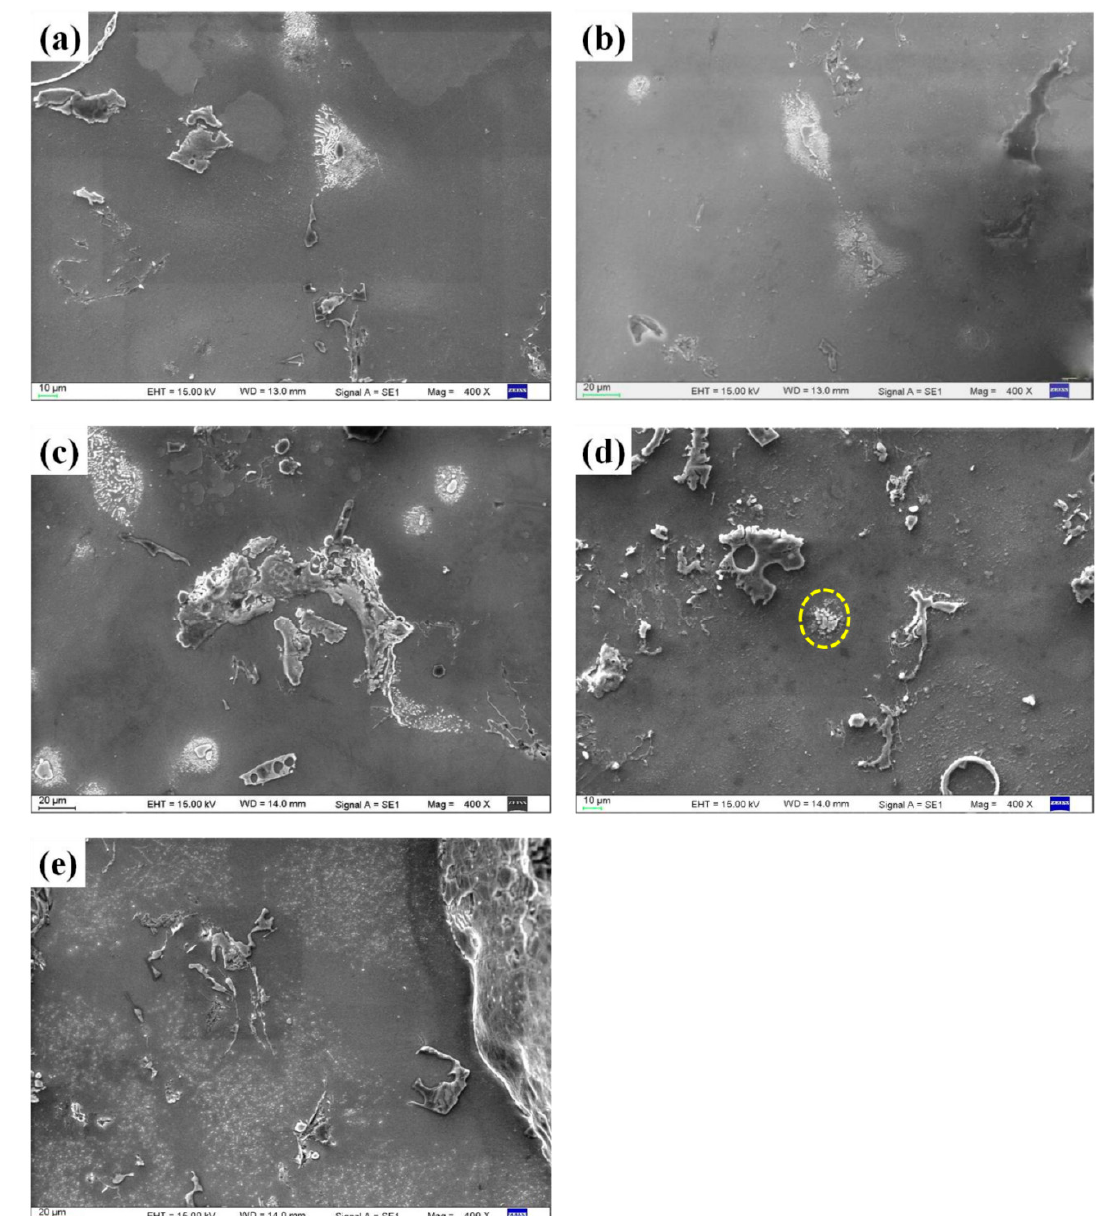
Figure 5. Morphology evolution of β -Mg 17 Al 12 in the composite foams heated for 2 h with different heating temperatures: ( a ) 150 °C, ( b ) 250 °C, ( c ) 320 °C, ( d ) 400 °C, and ( e ) 500 °C.